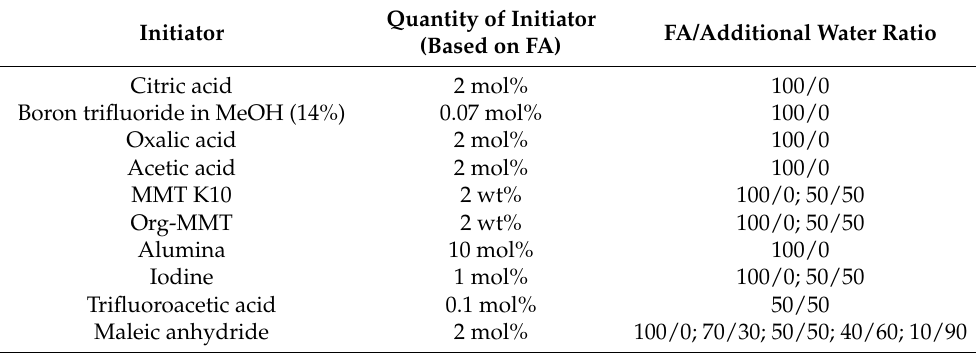
Table 1. FA’s polymerization